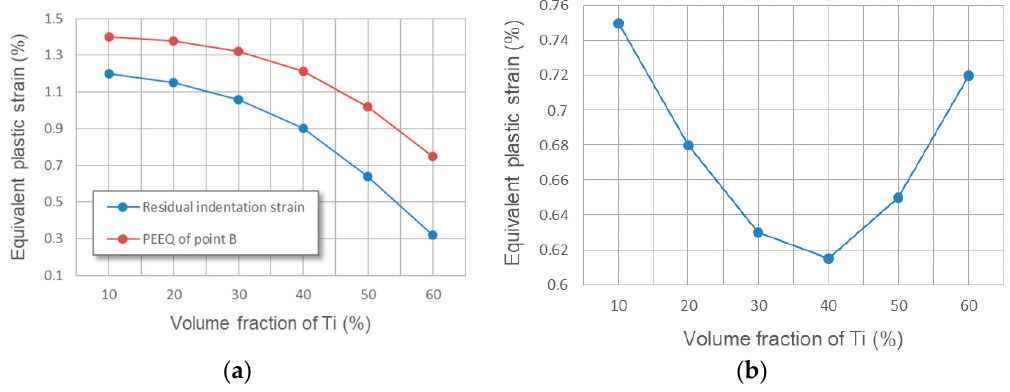
Figure 26. Plot of ( a ) the maximum plastic strain of residual indentation and the equivalent plastic strain of point B and ( b ) the average equivalent plastic strain of the Al 3 Ti layer with different volume fractions of Ti.